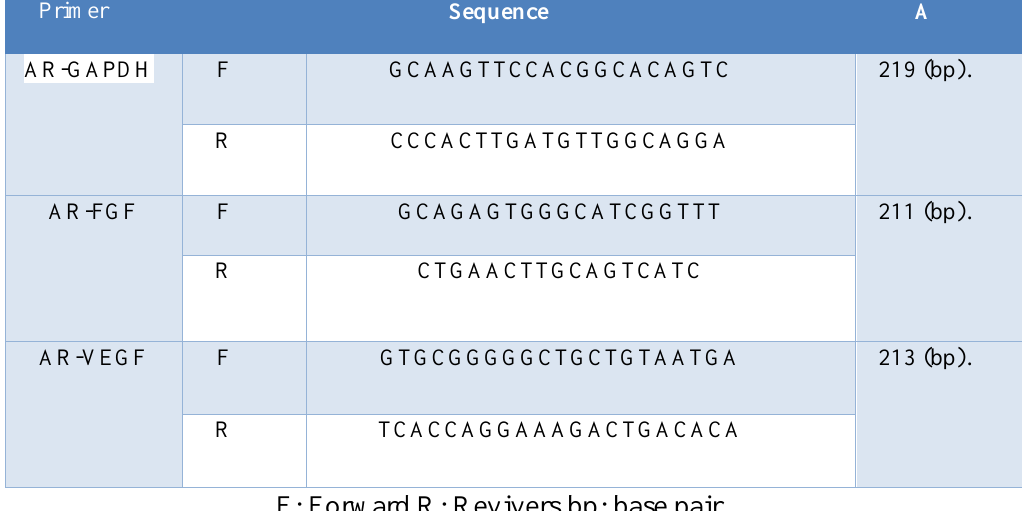
Table,1: The details of primers used in the study. Primer